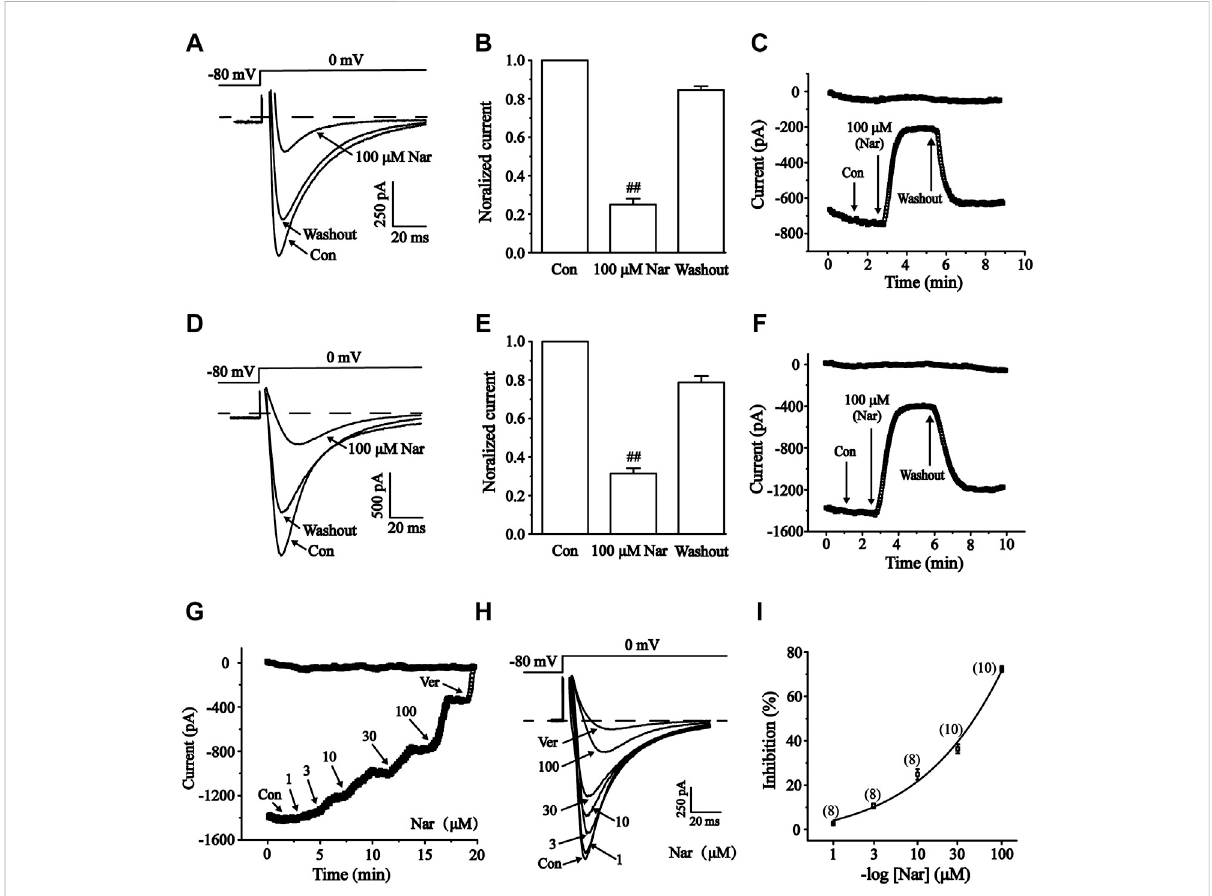
FIGURE 10 Reversible effects of Nar on I Ca-L in normal and ischemic ventricular myocytes. The corresponding letters and numbers are recorded on the main graphs to indicate the time. (A – C) Effects of Nar on I Ca-L in normal cardiomyocytes. (D – F) Effects of Nar on I Ca-L in ischemic cardiomyocytes. (A,D) Representative examples of I Ca-L , (B,E) summarized data and (C,F) time constant of I Ca-L were documented under Con, Nar (100 μ M) and washout conditions. Values were expressed as the mean ± SEM. Each group has 10 cells from fi ve to six rat hearts. ## p < 0.01 vs. Con group. During the periods indicated by horizontal lines, cells were continuously perfused with 1, 3, 10, 30 and 100 μ M Nar and 10 μ M Ver. (G) Time constantsand (H) typicaltraceswererecorded. (I) ThepercentageinhibitionofNarwasexpressedasconcentration-responsecurve,eachgrouphas eight to 10 cells from seven rat